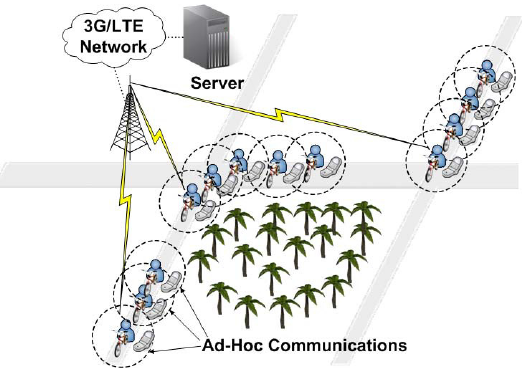
Figure 1. A two-tier mobile long-thin network formed by fleet